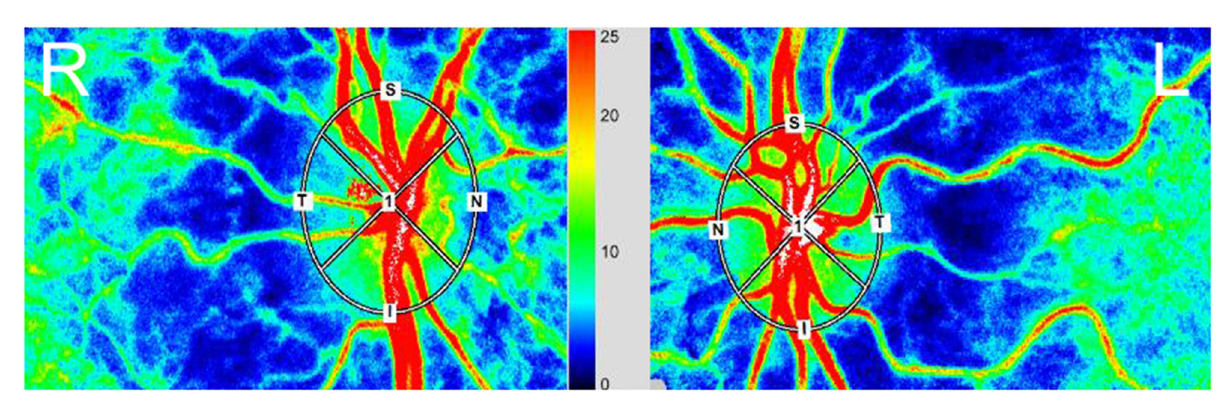
FIGURE1 Red, high blood flow; Blue, low blood flow. The margin in the optical nerve head (ONH) was determined manually using a rubber band. (Right) eye (R), fellow eye. (Left) eye (L), amblyopic eye.